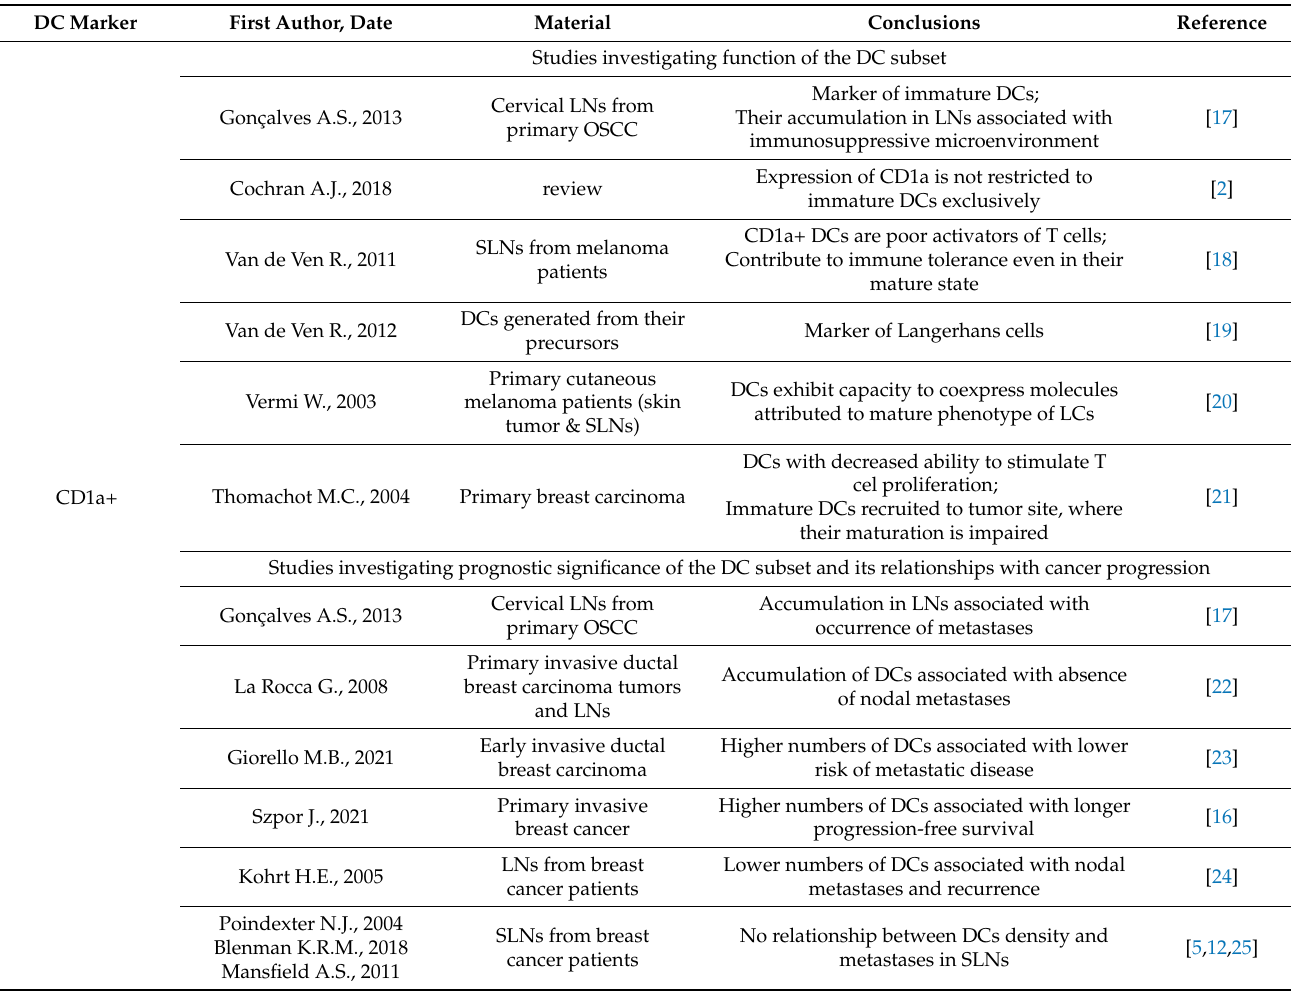
Table 3. Studies that investigated function of DC subsets and their role in